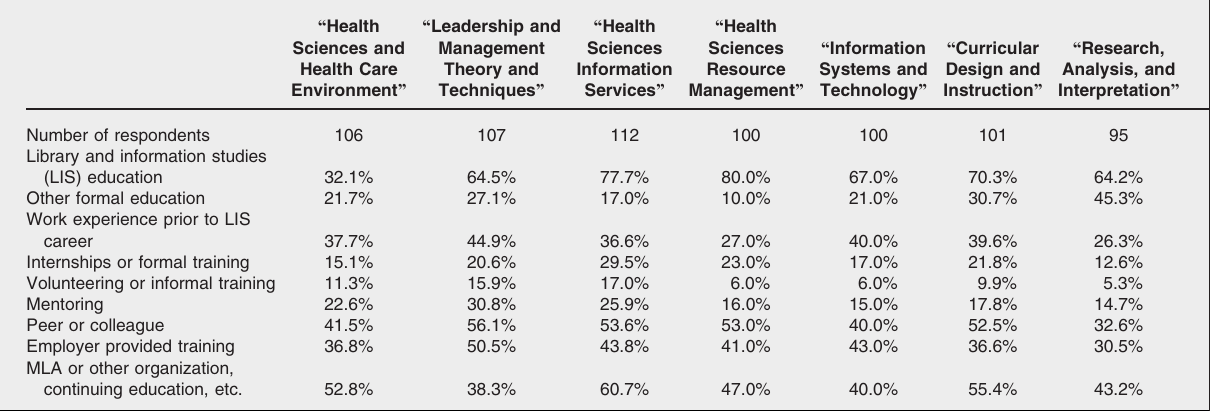
Methods of attaining text responses to the Likert scale. The 2 negative responses indicated that the participants felt they